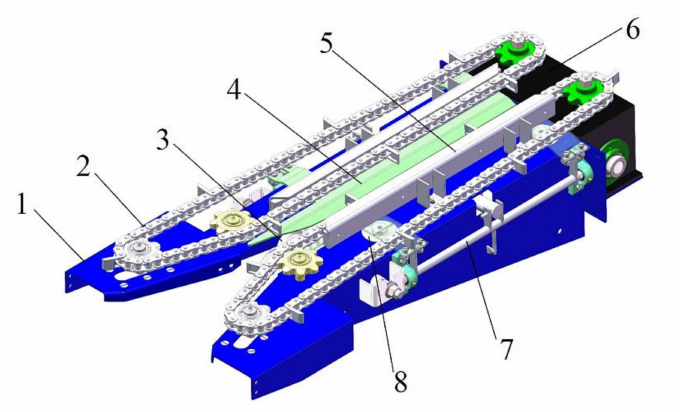
Figure 6. Structural figure of low-damage snapping mechanism. (1) Frame; (2) feeding chain; (3) stalk roller; (4) snapping plate; (5) chain guard; (6) gearbox; (7) snapping plate gap adjustment device; (8) damping